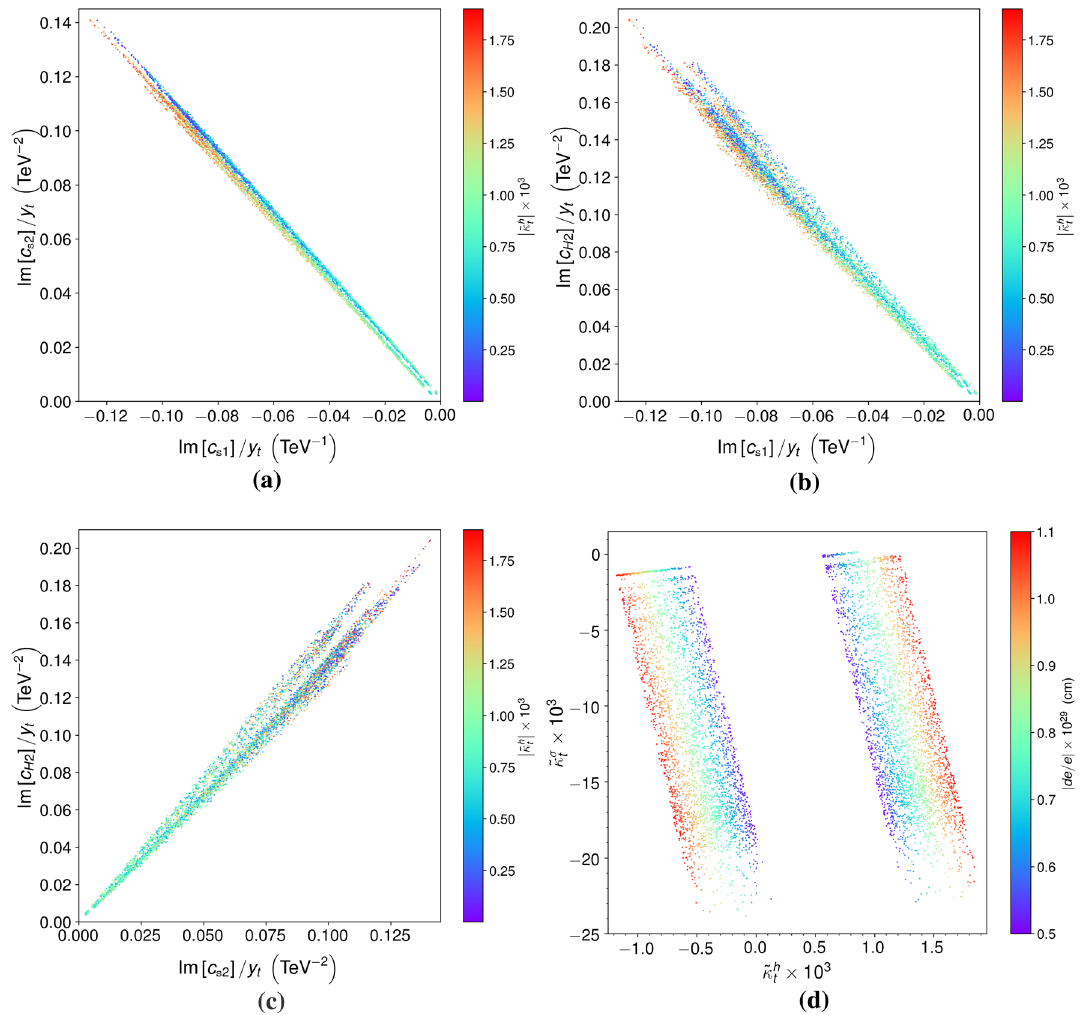
] / y [ c t ] / y [ c t ] / y ˜ κ h ˜ κ σ t , Im t , Im t , t and t for the points of our ML s 1 s 2 H 2